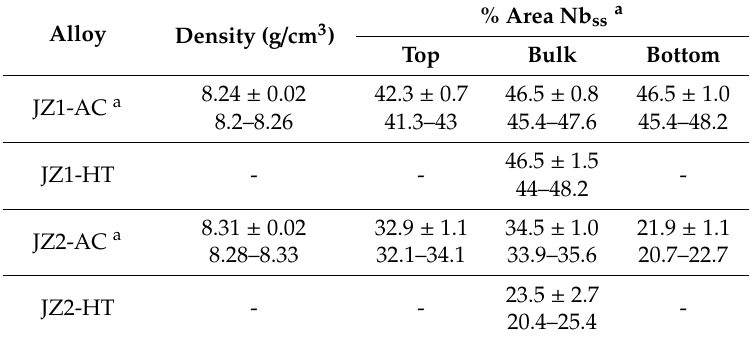
Table 2. Density of the as-cast (AC) alloys and % area of Nb ss in the as-cast and heat-treated (HT) alloys JZ1 and